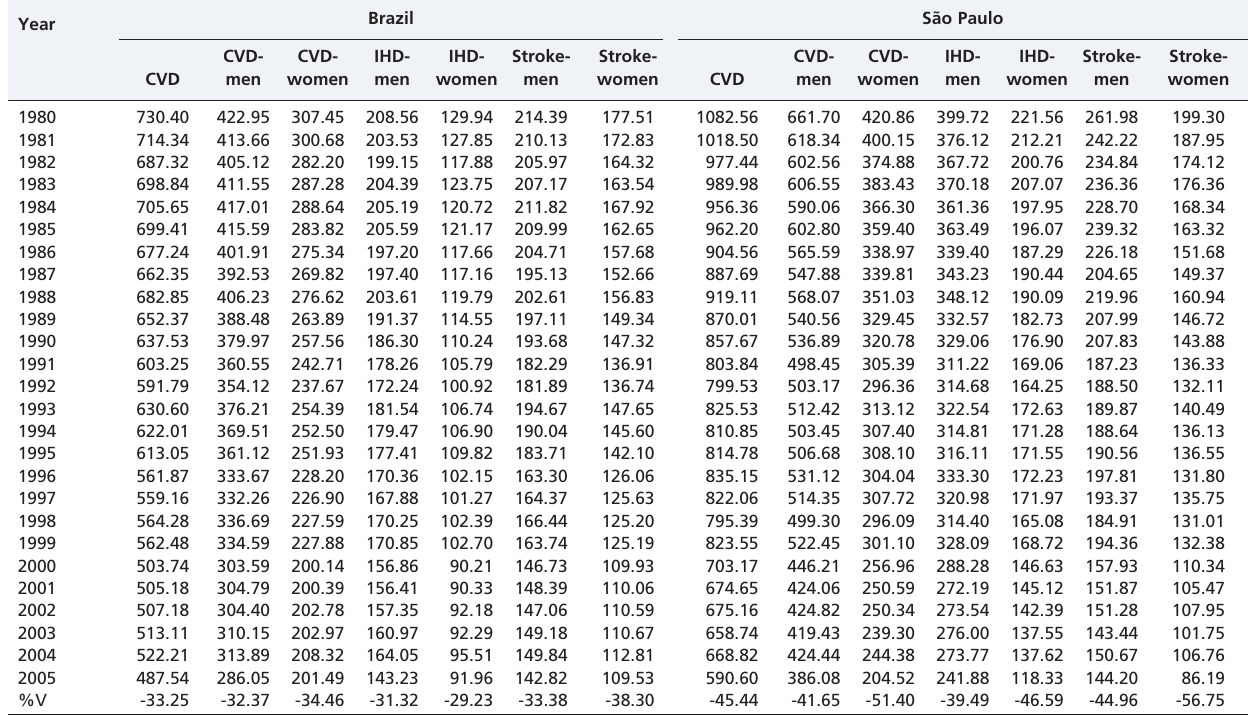
Table 1 - Death rates associated with cardiovascular disease (CVD), ischemic heart disease (IHD), and stroke.